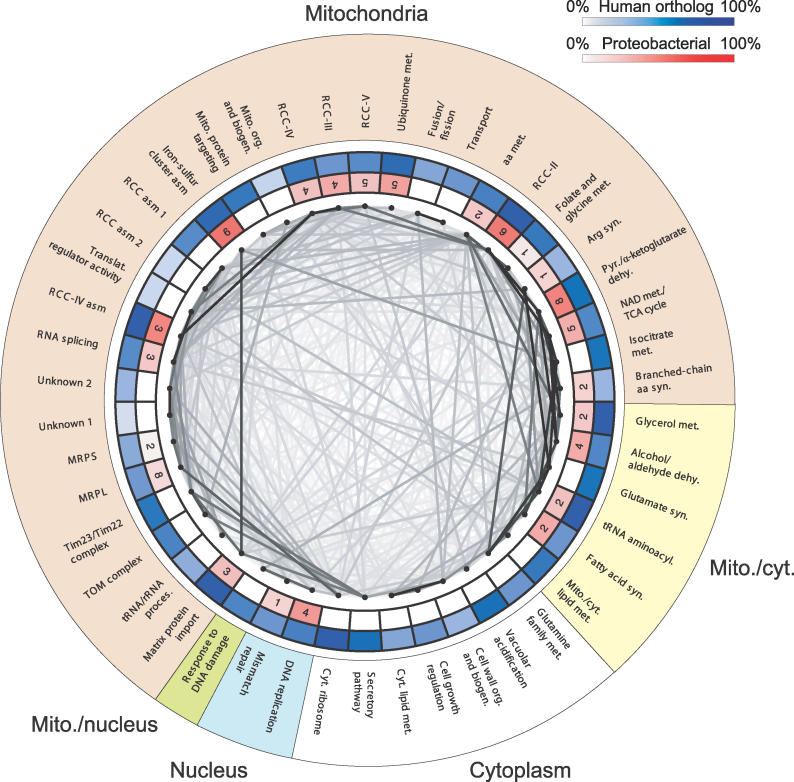
Origin and Conservation of the Mitochondrial SystemOrthology was used to identify functional processes in yeast that originate from bacteria and are conserved to humans. Modules of five or more proteins are shown as single nodes at the circumference of the circle and the degree of evidence connecting modules is shown by lines in different gray tone. The connection between modules is calculated as the average of the STRING interaction scores for all protein-pairs. Modules are distributed according to their localization. Color in the inner rings reflects for each module the percentage of proteins that have proteobacterial orthology (red) or human orthology (blue). The number of proteobacterial orthologs is also indicated.